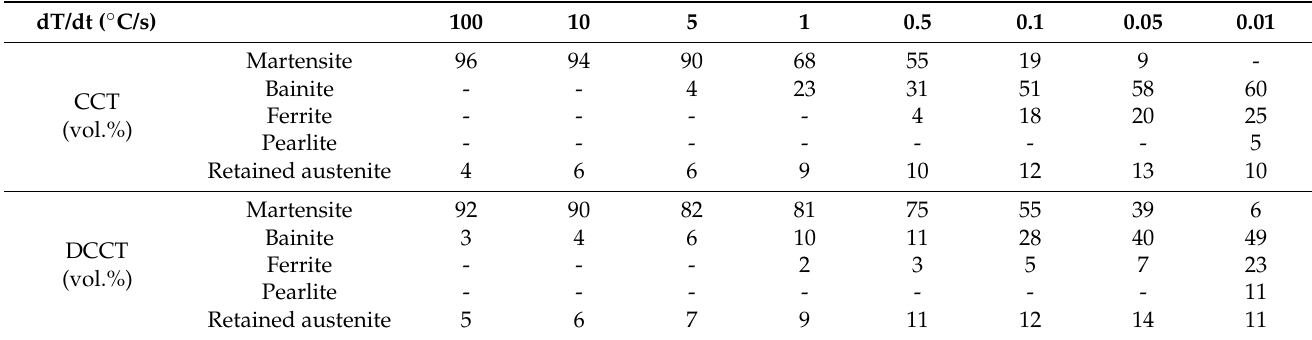
Figure 10. Determination of phase fraction from the dilatometric cooling curves in CCT and DCCT mode by lever lure for 0.05 °C/s. Table 4. Phase fractions determined from CCT and DCCT